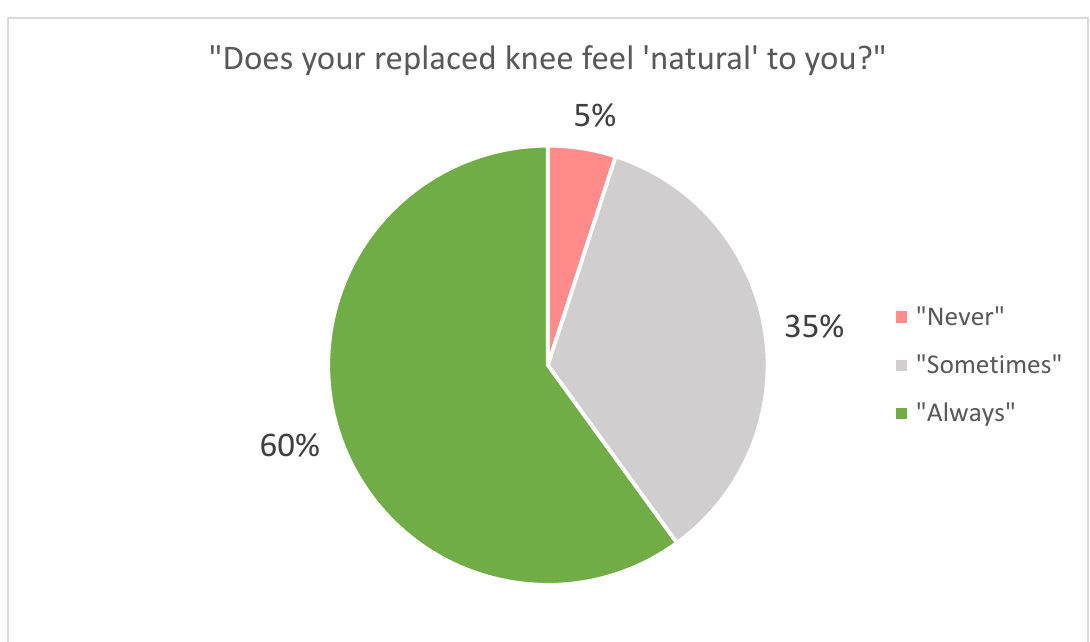
Figure 3. Responses to “Does your replaced knee feel ‘natural’ to you?”